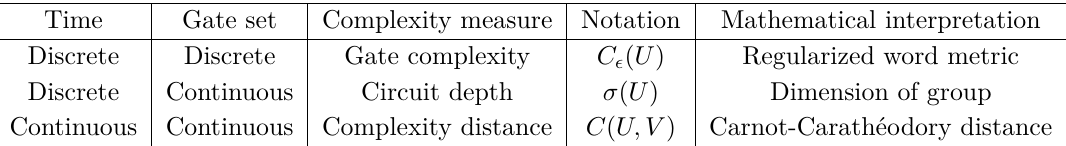
Table 1 . A summary of the various notions of quantum complexity that we consider in this